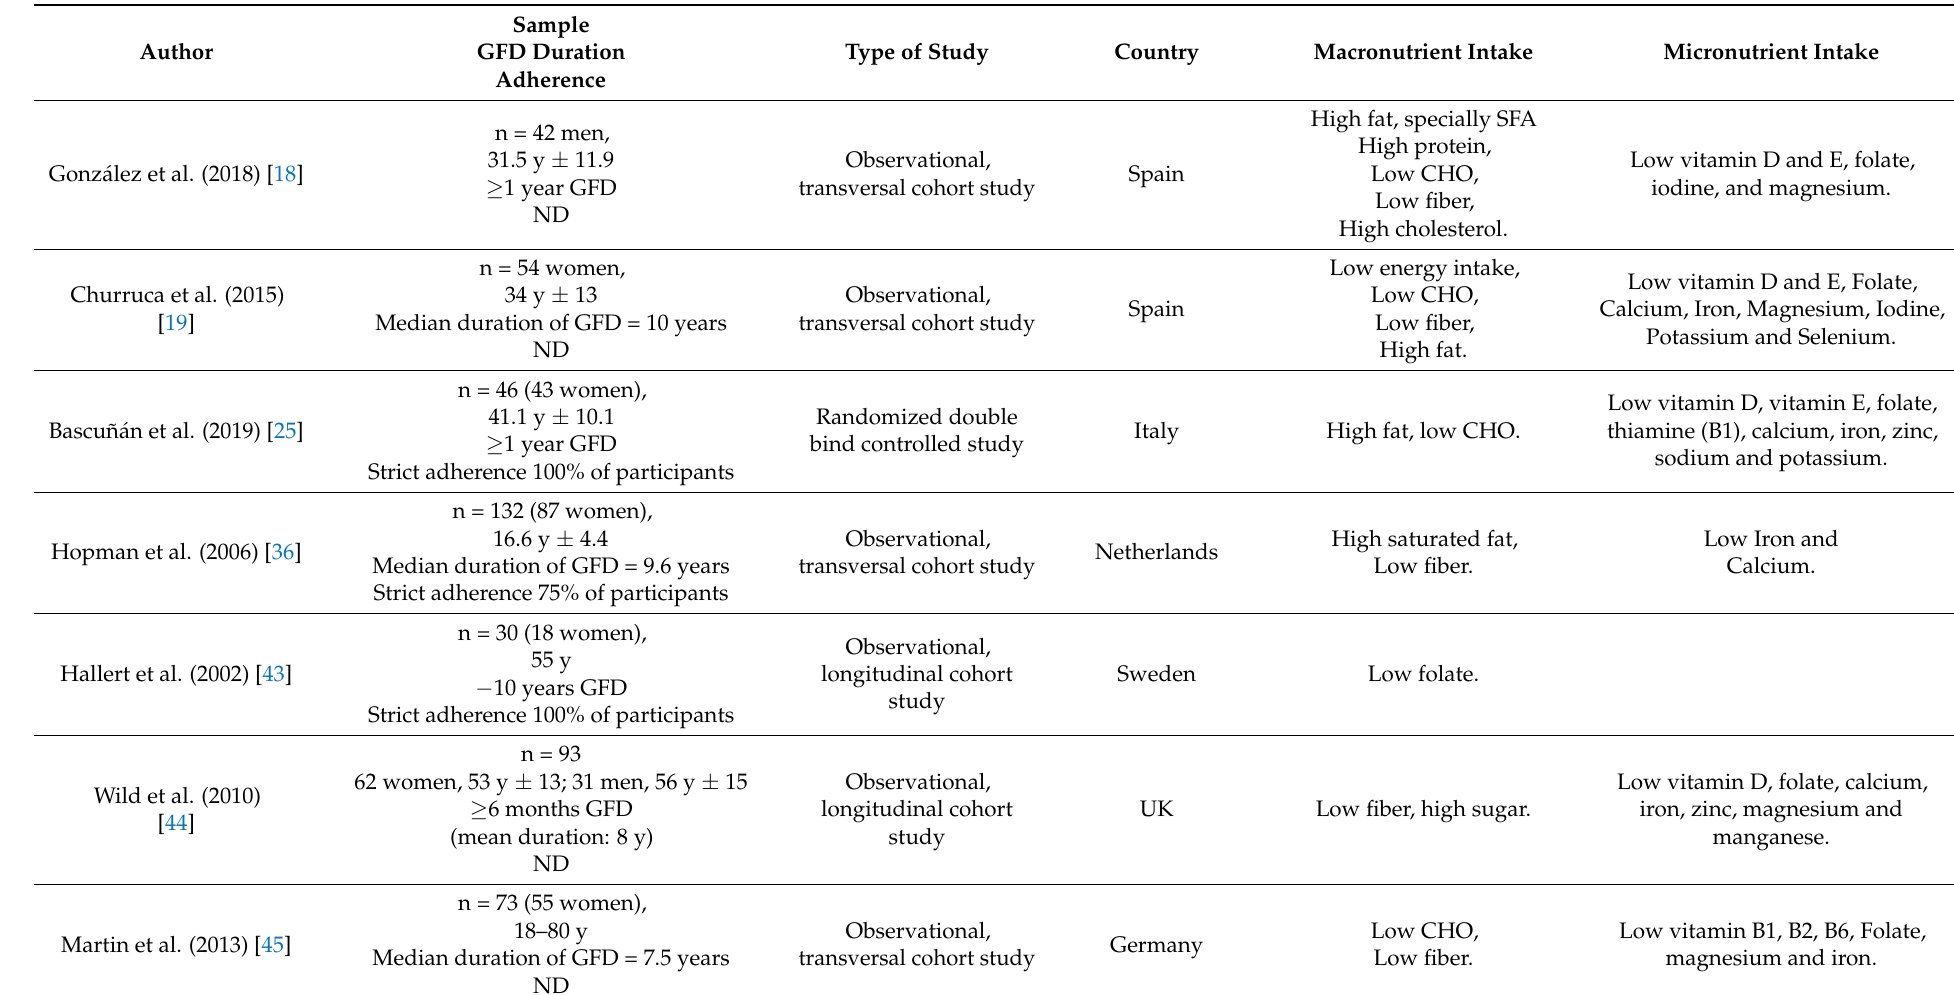
Table 2. Dietary profile of people with celiac disease following a